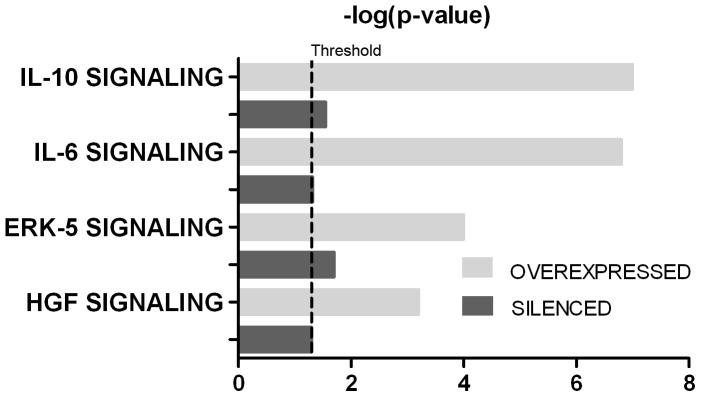
Common pathways significantly affected by both syndecan-1 overexpression and silencing, revealed by Ingenuity Pathway (IPA).Canonical pathway analysis identified the pathways from the IPA library that were most significant to the data set. Molecules from the data set that met the cutoff of FC≥1.5 or FC≤−1.5 and q≤0.05 and were associated with a canonical pathway in the Ingenuity Knowledge Base were considered for the analysis. The significance of the association between the data set and the canonical pathway was measured by Fisher’s exact test. Grey columns denote syndecan-1 overexpression and black columns denote syndecan-1 silencing. Bars represent the logarithmic values of the significance level (p), the dashed line represents the threshold of p = 0.05.